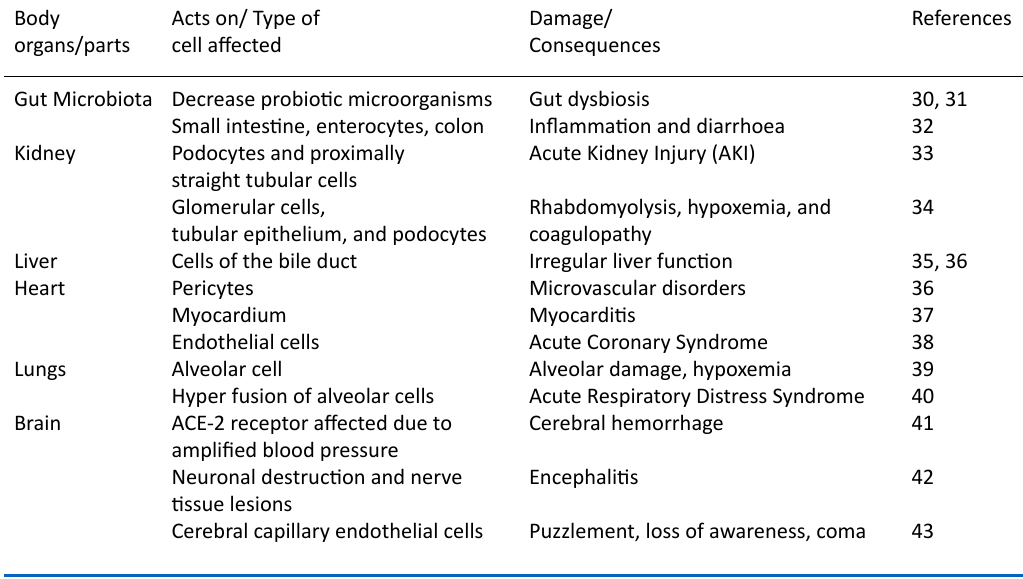
Table 1. List of body parts affected by COVID-19 and its deleterious effects Body Acts on/ Type of